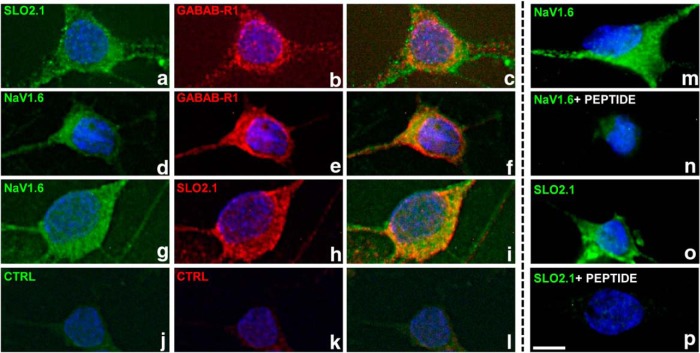
The GABA-B receptor (GABAB-R1) colocalizes with sodium-activated potassium channels (SLO2.1) and voltage-sensitive sodium channels (NaV1.6). Rat olfactory bulb primary neurons were immunostained with pairwise combinations of primary antibodies (indicated at top left) raised from different species, followed by staining with fluorophore-coupled secondary antibodies. Panels c, f, and i are merged images, demonstrating that both proteins are present in the same cell. As with other channels and receptors, there is likely an intracellular pool as well a cell-surface pool, consistent with previous results (Panzanelli et al., 2004). Control samples incubated without any primary antibody show negligible staining (panels j, k, and l). The last column shows additional examples of immunostaining for SLO2.1 or NaV 1.6 in the absence or presence of the antigenic peptide (panels m, n, o, and p); the immunostaining is dramatically reduced in the presence of the peptide. Scale bar in p: 5 μm.